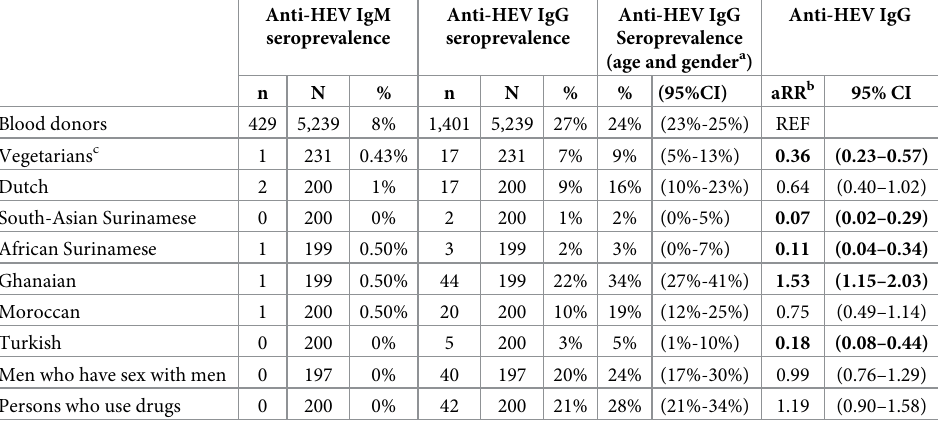
Table 1. Anti-HEV immunoglobulin M (IgM) and IgG seroprevalence in various research populations from the